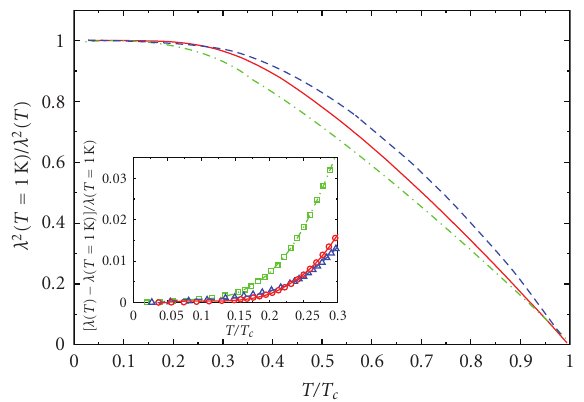
Figure 6: Calculated temperature dependence of the penetration depth ([ λ ( T ) /λ ( T = 1K)] 2 ) for LaFeAsO 0 . 9 F 0 . 1 ( T c = 27K, red solid line), Ba 0 . 6 K 0 . 4 Fe 2 As 2 ( T c = 37K, dash blue line), and for SmFeAsO 0 . 8 F 0 . 2 ( T c = 52 K, green dash-dot line). The insert shows the behaviour of [ λ ( T ) − λ ( T = 1K)] /λ ( T = 1K) obtained by solution of Eliashberg equations: red circles for LaFeAsO 0 . 9 F 0 . 1 , dark blue triangle for Ba 0 . 6 K 0 . 4 Fe 2 As 2 , green squares for SmFeAsO 0 . 8 F 0 . 2 . The lines are the third-order polynomial